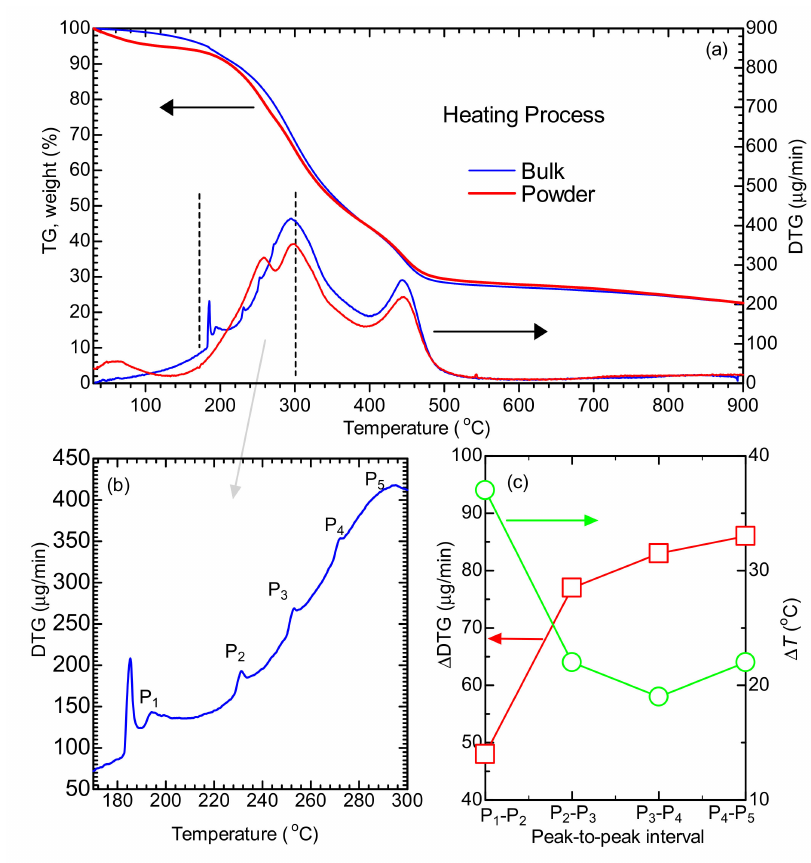
Figure 2. Thermogravimetric (TG) analysis and differential thermogravimetry (DTG) analysis of B. braunii residues. ( a ) TG and DTG curves of the B. braunii residues in the heating process for bulk and powder form; ( b ) DTG result of the B. braunii residues of bulk form in the range of 170–300 ◦ C; ( c ) ∆ DTG and ∆ T as a function of peak-to-peak interval obtained from Figure